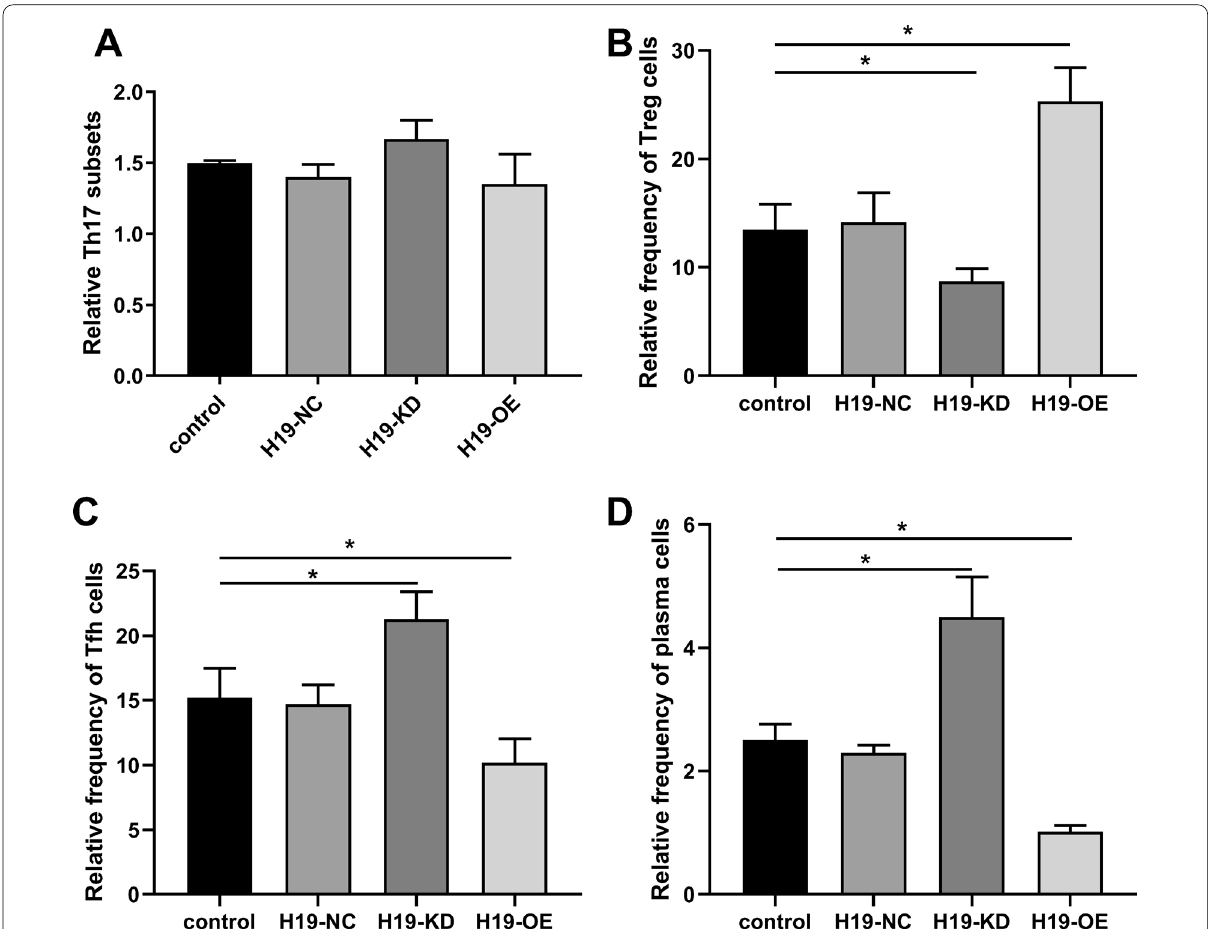
Fig. 3 H19 inhibited the immunoregulatory function of BMMSCs. BMMSCs from SLE patients were transfected with H19-NC, H19-OE or H19-KD and then co-cultured with PBMCs at a ratio of 1:10 for 3 days. A Percentages of Th17 cells. B The proportion of Treg cells. The proportion of Tfh cells ( C ) and plasma cells ( D ). n 6. *P < =